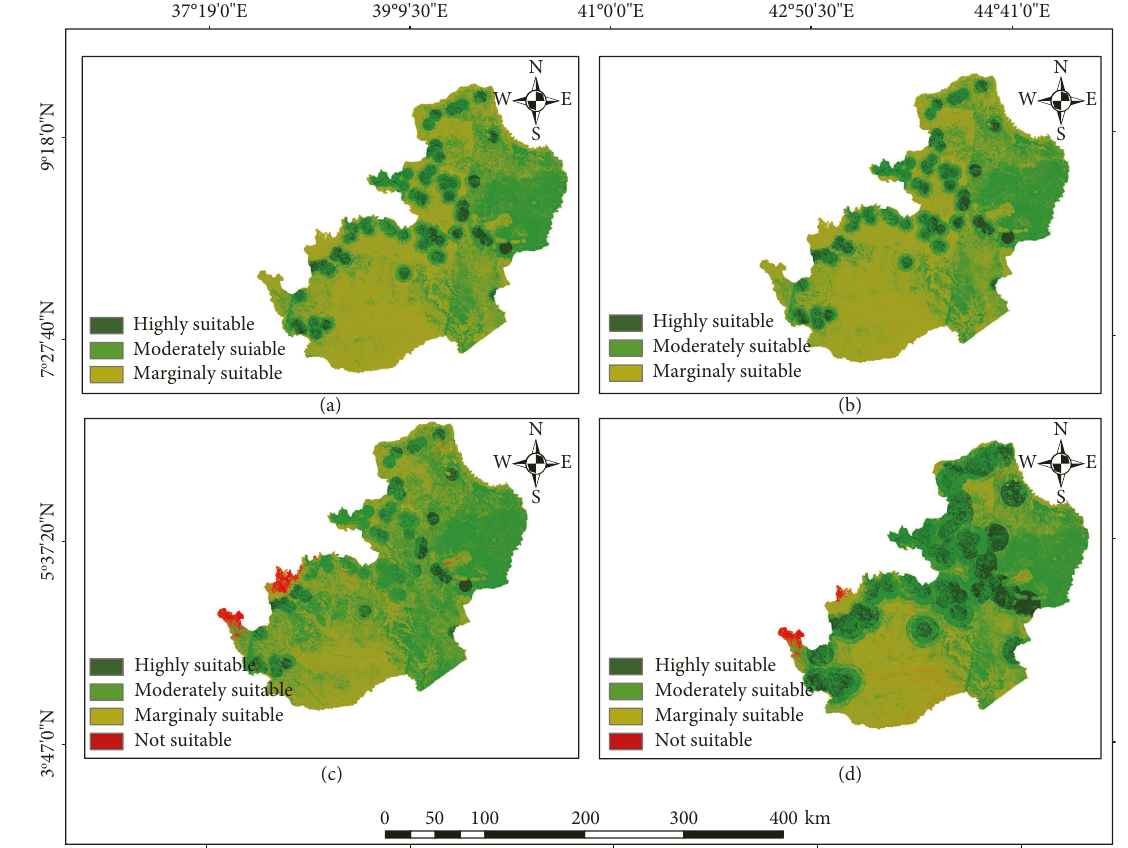
Figure 12: Rangeland suitability map for (a) camel, (b) goat, (c) sheep, and (d)